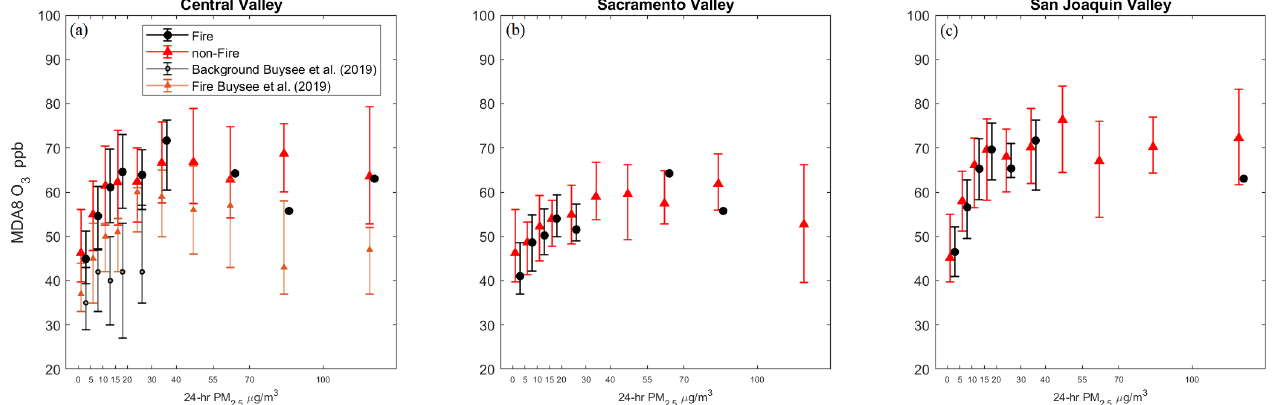
Figure 4. Plots for binned 24h PM 2 . 5 vs. MDA8 O 3 for all 10 sites (a) . Chico, Yuba City, and Sacramento are in (b) and all other sites in the SJV in (c) . Black dots and red triangles denote the median value for the background and wildfire periods, respectively. The error bars denote the 25th and 75th percentile values. The number of data points in each bin can be found in Table C3. The orange (fire) and gray (non-fire) error bars are the results reported by Buysee et al. (2019) for